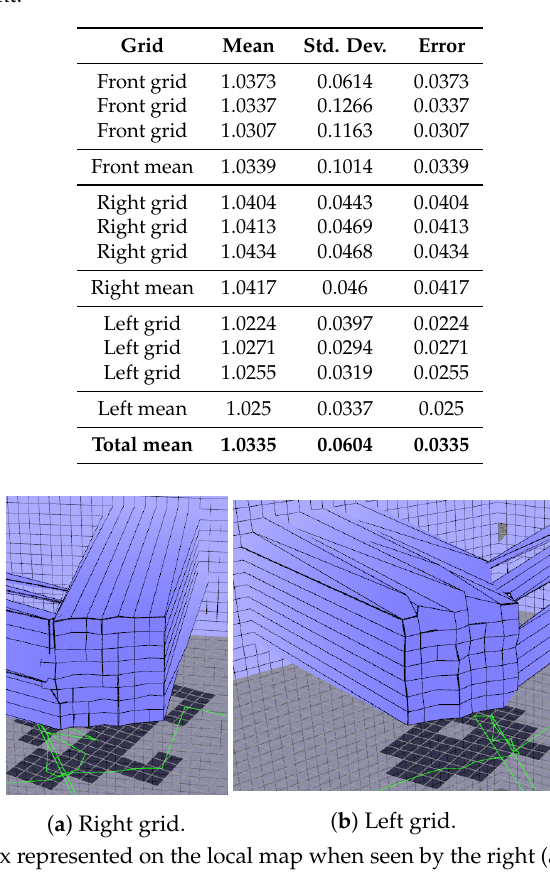
Table 2. Distance measurement results when the box is a meter away in front of the robot or 45 degrees to the left or to the right.